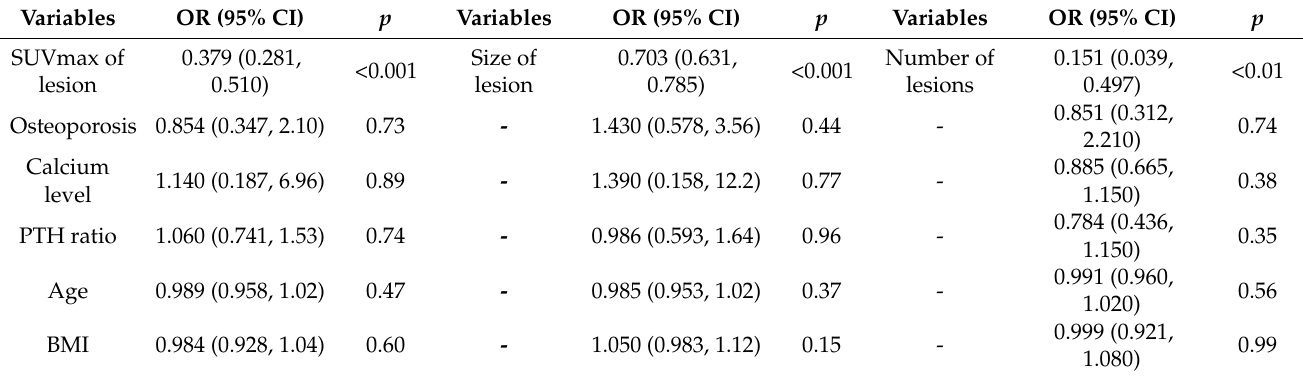
Table 4. Correlation between 18 F-choline positron emission tomography/contrast-enhanced com- puted tomography and surgical